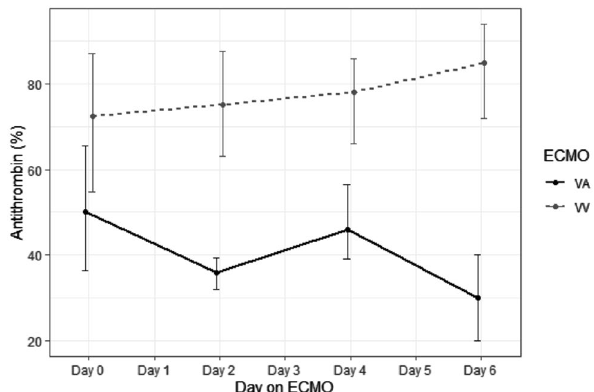
Figure 4. Antithrombin percentage over first week of ECMO support.